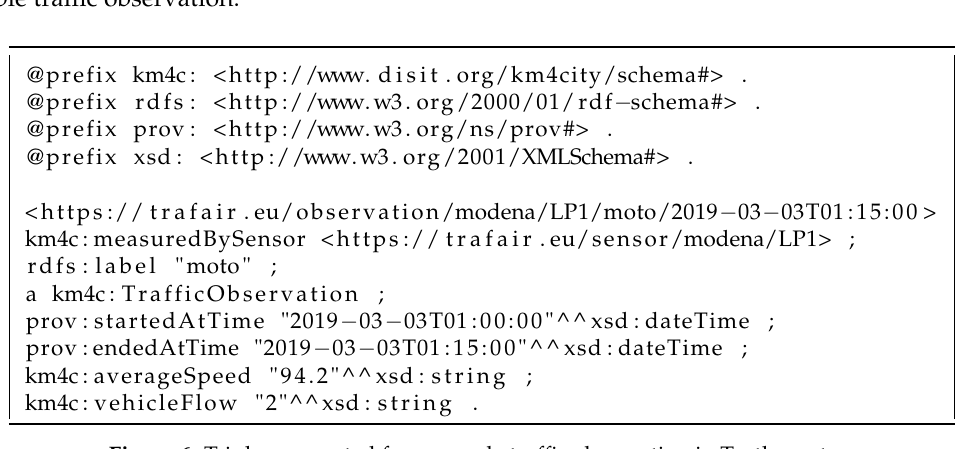
Figure 6. Triples generated for a sample traffic observation in Turtle